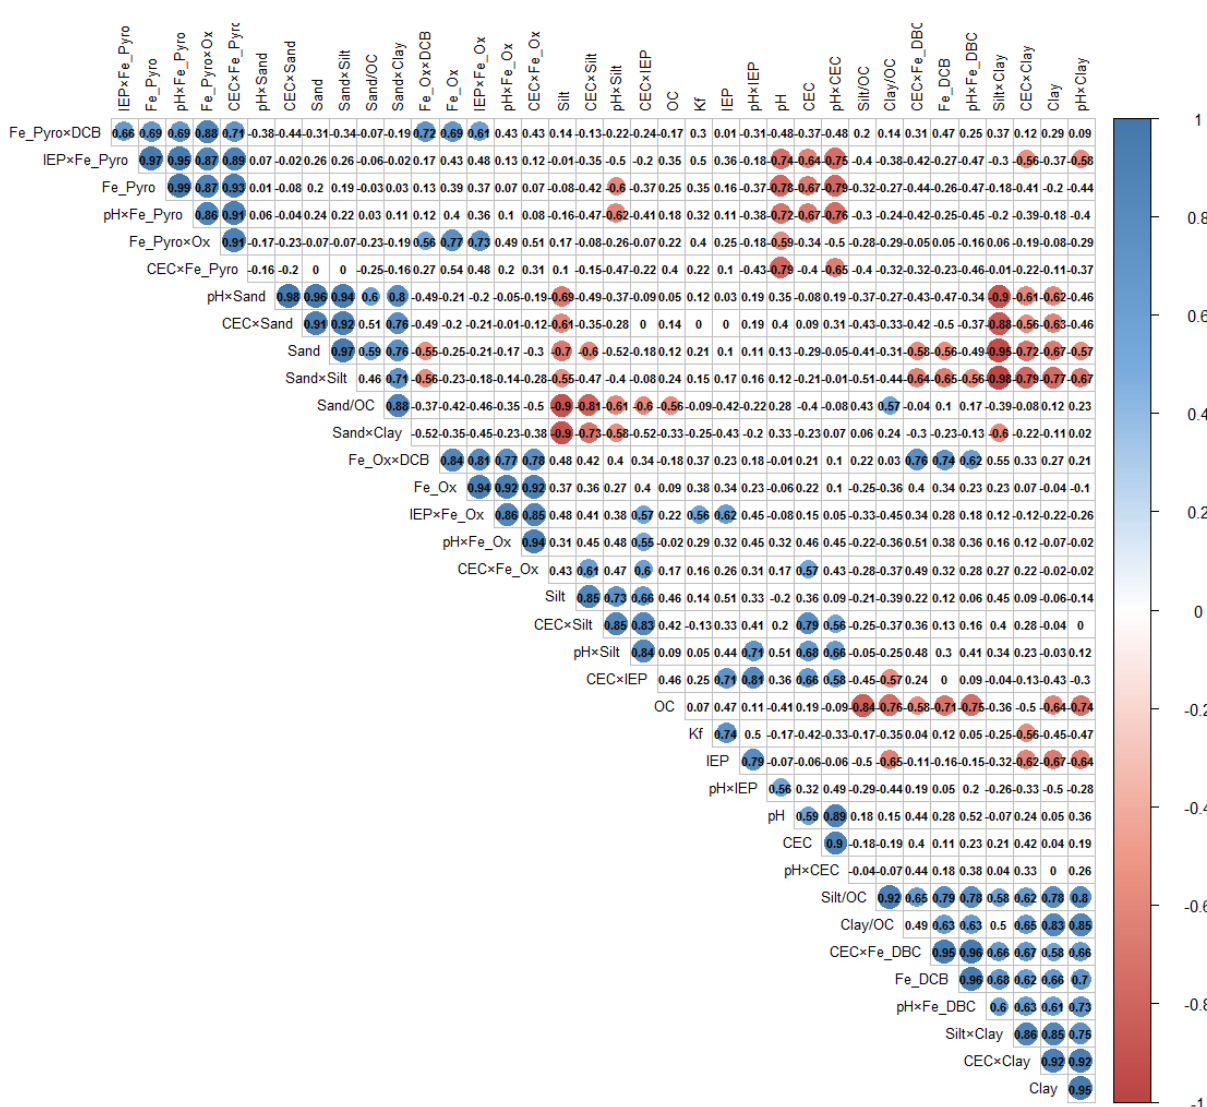
Figure 2. Correlogram of VADS properties and sorption coefficients. Pearson correlation coefficients are proportional to color intensity and the size of the circle.